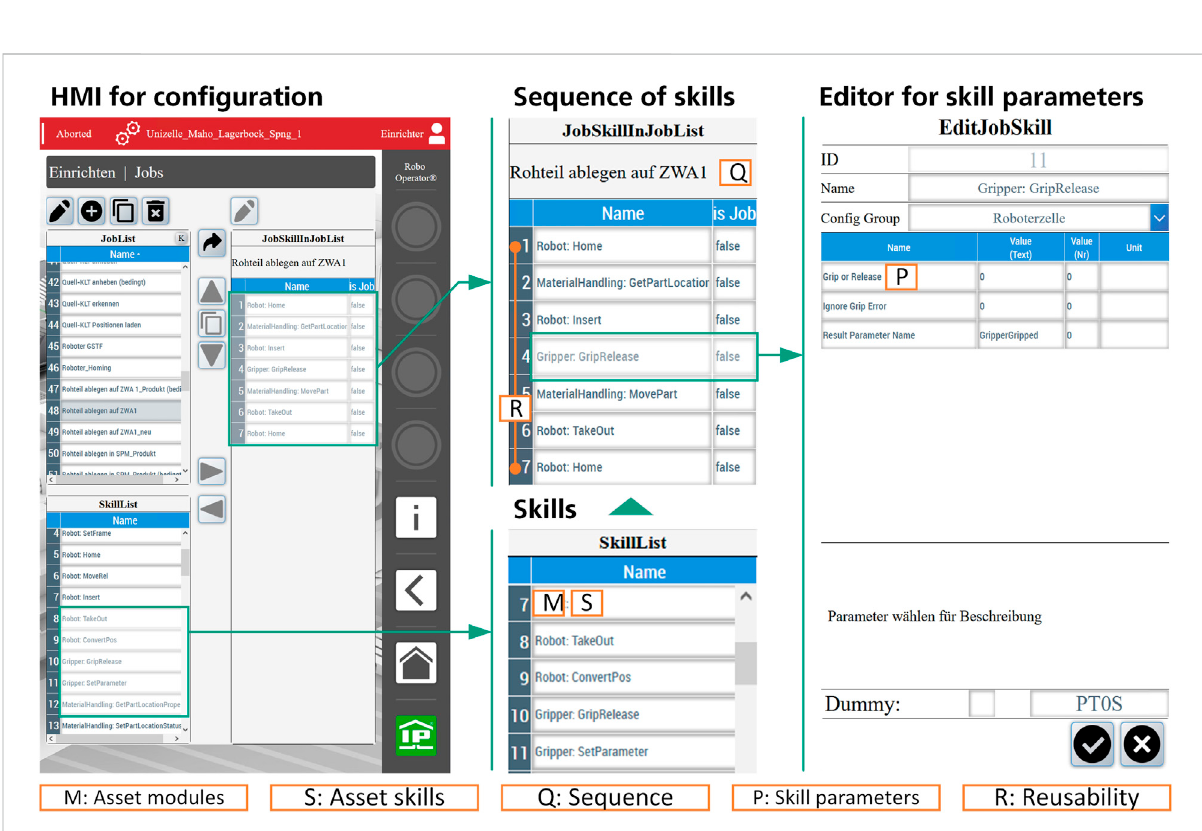
Composition of the module skills to sequences and skill parameterization through the con fi guration